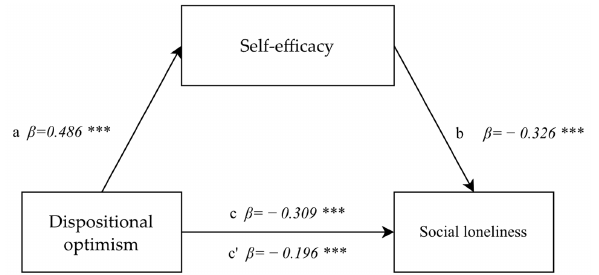
Figure 3. The model of a mediatory role of self-efficacy between dispositional optimism and social loneliness. Explanation: Statistically significant: *** p < 0.001.